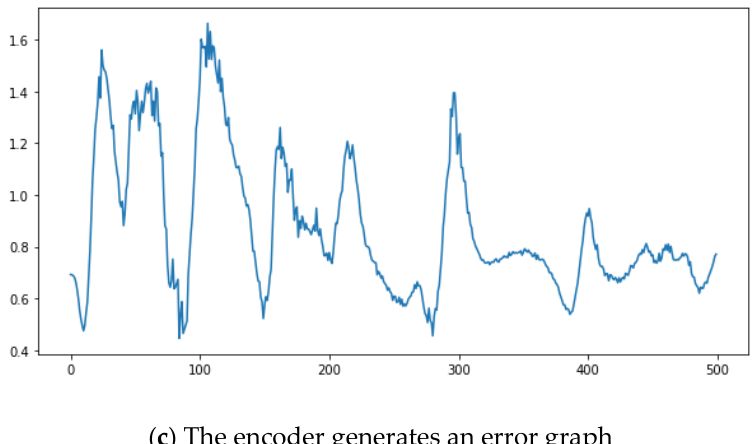
Figure 6. AAE model loss function change curve.